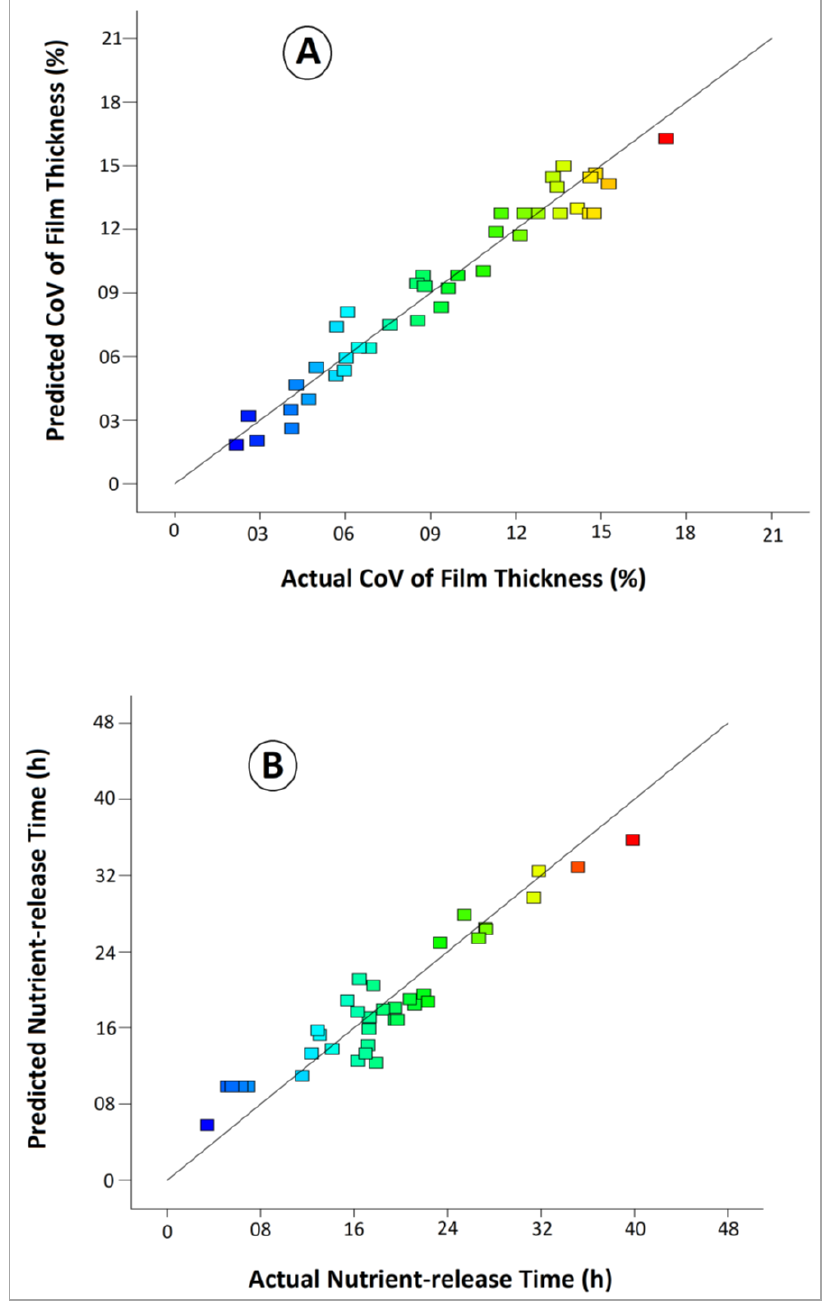
Figure 8. Actual vs. predicted ( A ) coefficient of variance (CoV) of the film thickness and ( B ) nutrient- release time. Table 5. Optimum process parameters, experimental response, and % error.